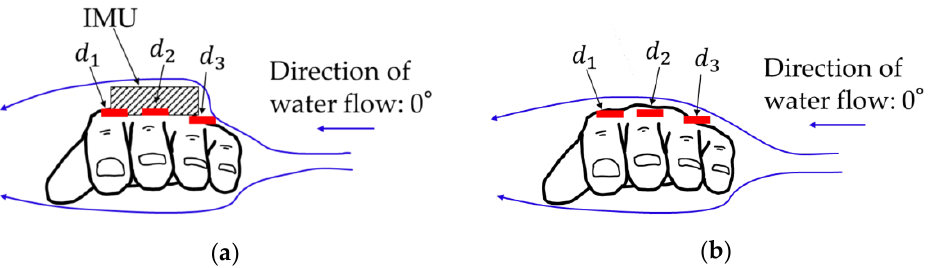
Figure 10. Conceptual diagram showing difference in water flow around hand with ( a ) and without ( b ) the IMU.